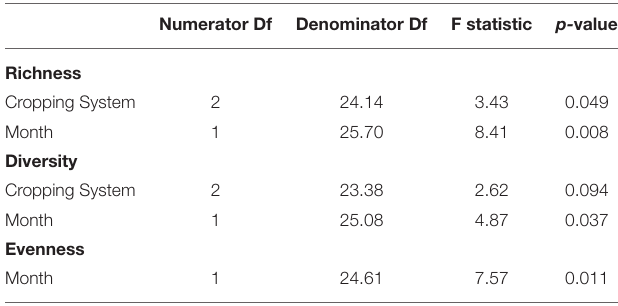
TABLE 1 | Statistics from Type III Analysis of Variance for mixed effect linear models of bacterial richness, Shannon’s Diversity, and Shannon’s Evenness.